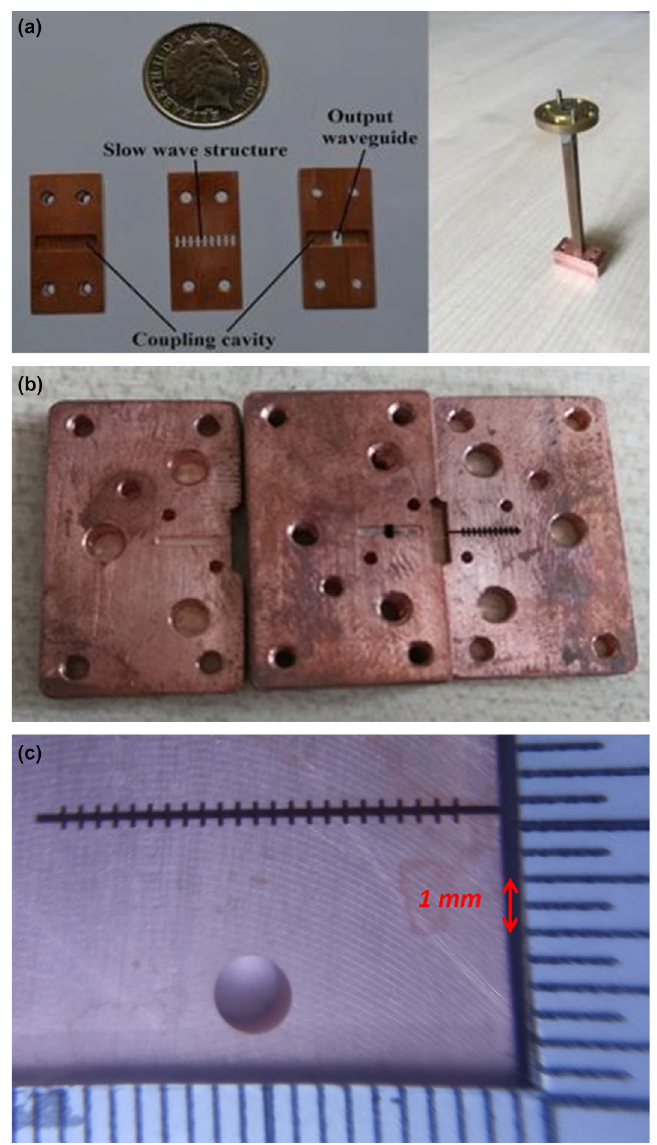
Figure 2. The machined parts of the EIO structure. ( a ) W-band EIO and its assembly, ( b ) The G-band EIO parts before assembling, ( c ) The wire cut 350 GHz slow-wave structure in the major EIO